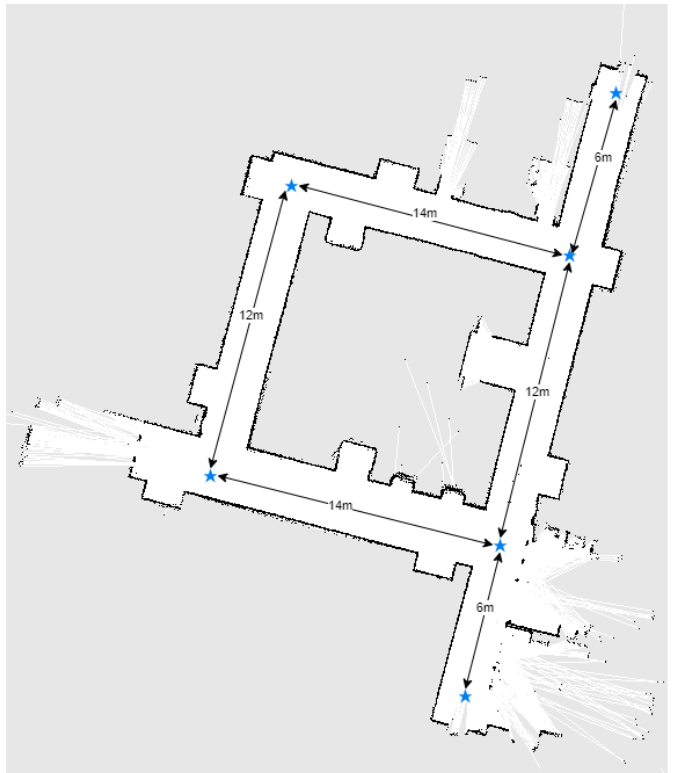
Figure 15. Large scale indoor mapping results. Marked with the blue stars are the goals set to the robot. The distances between goals are marked on the